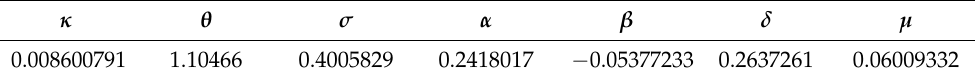
Table 3. Estimation Result of OU and LDOU model on fuel-switching